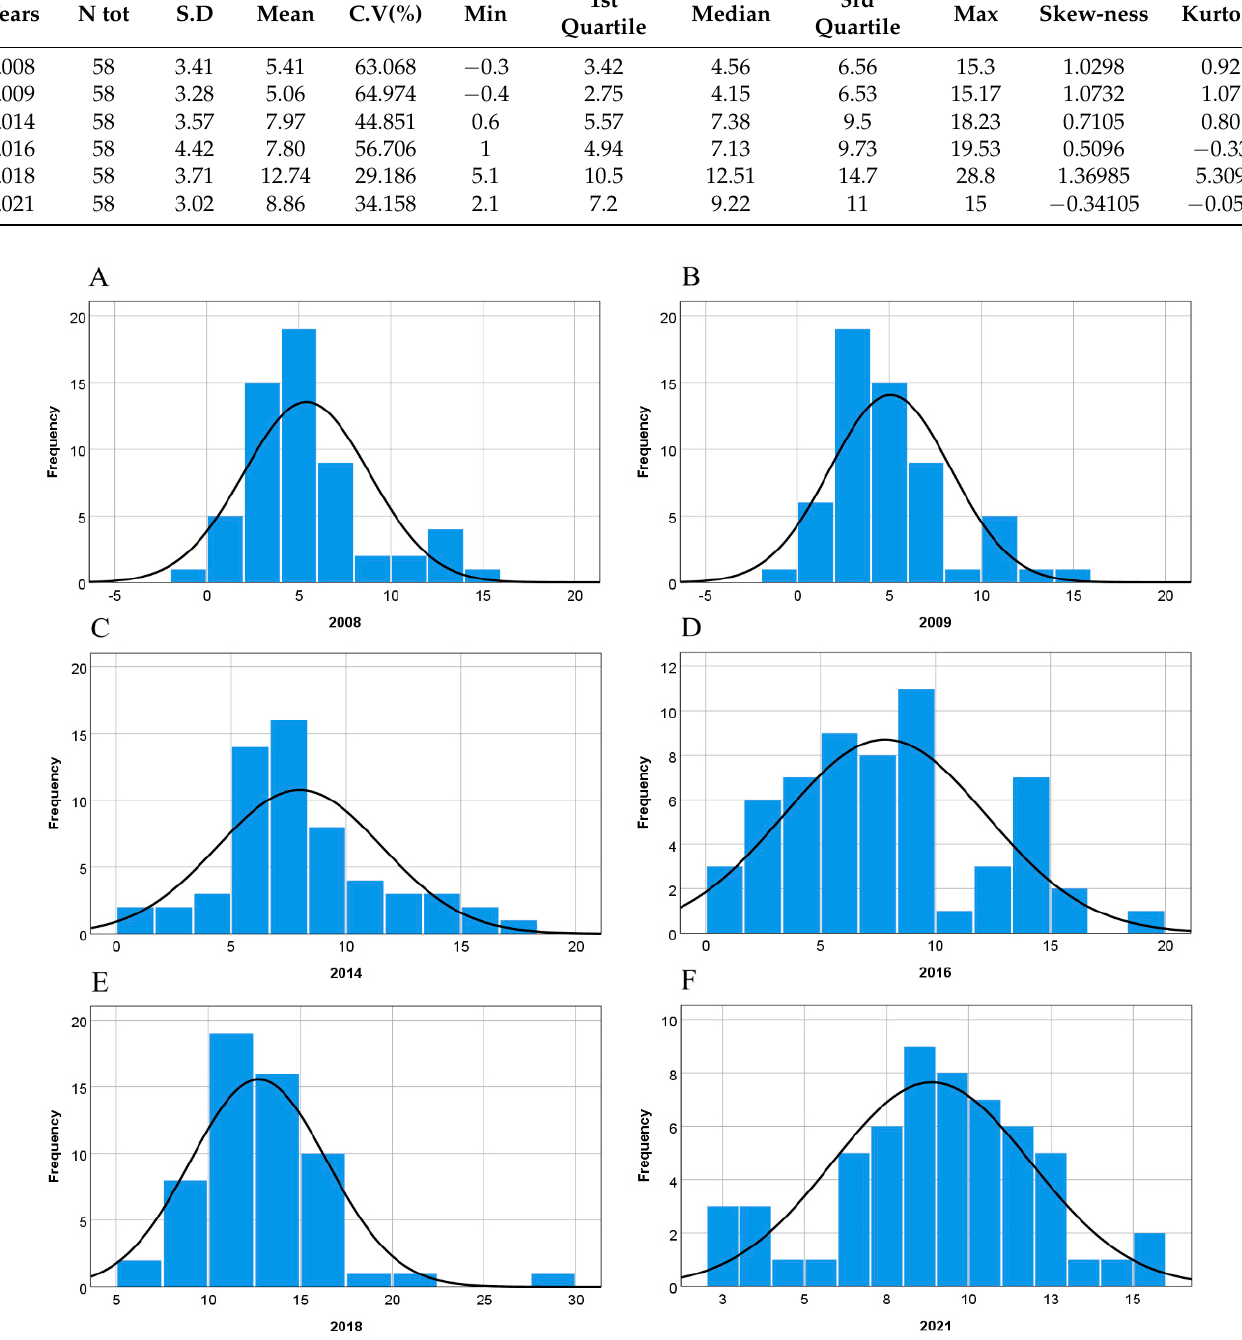
Figure 7. Histograms of normality tests: ( A ) 2008, ( B ) 2009, ( C ) 2014 ,( D ) 2016, ( E ) 2018, ( F ) 2021. There is a slight degree of anisotropy, which means that the created experimental semivariograms for the different directions have some differences in their sills and in- fluence ranges. As a result, the discovered anisotropies were overlooked, and isotropic models were used instead. At the same time, mean error (ME) and root mean square standard- ized error (RMSSE) values have been considered for the selection of the best fitted semi- variogram models. Whereas, the evaluation of the selected model was conducted based